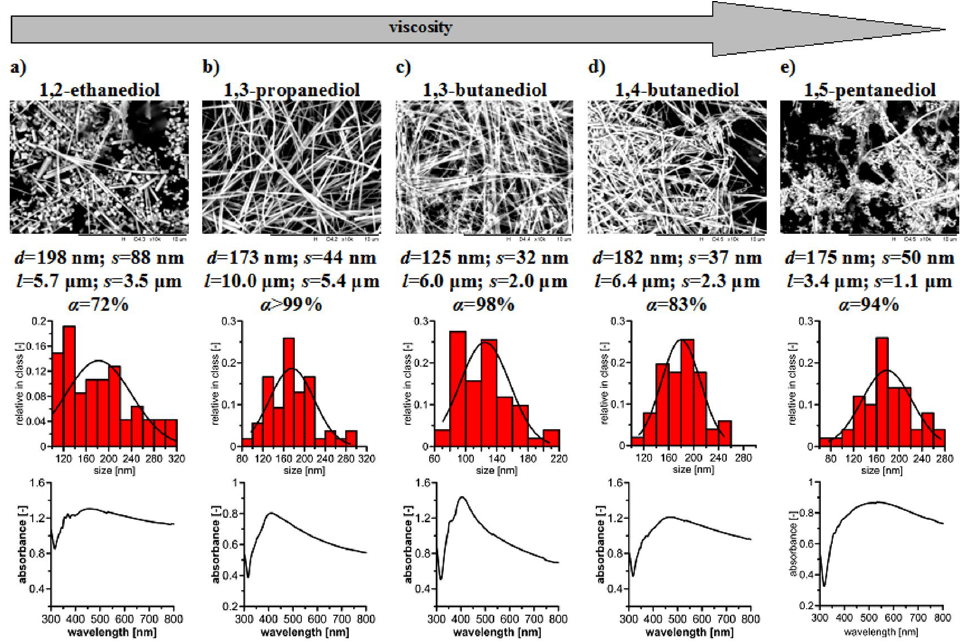
Figure 7. A summary of the properties of AgNWs produced in a batch, microwave-assisted process: d, l = average diameter, length, respectively; s = standard deviation; α = conversion; scale bar 10 μm. reductants in a batch, microwave-assisted process: ( a ) 1,2-ethanediol, ( b ) 1,3-propanediol, ( c ) 1,3- butanediol, ( d ) 1,4-butanediol, ( e ) 1,5-pentanediol. d , l —average diameter, length, respectively; s —standard deviation; α —conversion; scale bar 10 µ